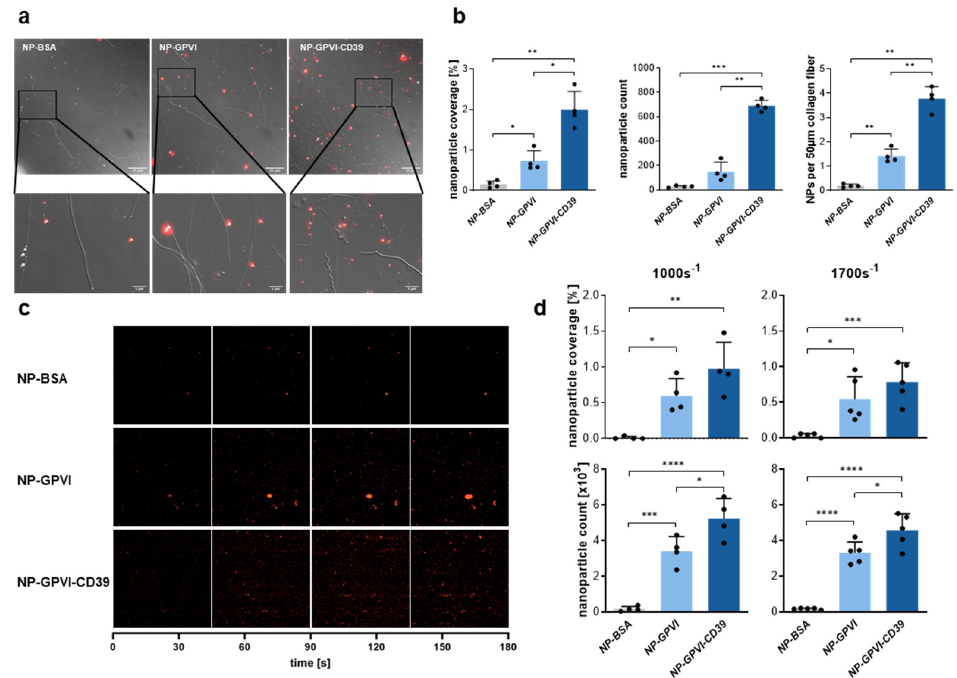
Figure 5. Collagen receptor GPVI-Fc- and GPVI-CD39-coated nanoparticles effectively bind to collagen fibers under both static and dynamic conditions. ( a ) Merged DIC and fluorescence microscopy images of nanoparticles adhered onto collagen coated cover slips after 1 h incubation at 37 °C. 100× magnification. Scale bar: upper row, 25 μ m; lower row, 5 μ m. ( b ) Statistical analysis of nanoparticle coverage, total nanoparticle count and nanoparticle count per 50 μ m of collagen fiber. Mean ± SD; n = 4; ordinary one-way ANOVA; * p ≤ 0.05, ** p ≤ 0.01, *** p ≤ 0.001. ( c ) Representative time-series images depicting nanoparticles adhering to collagen-covered cover slips in flow chamber experiments at HS (1700 s − 1 ). 20× magnification. ( d ) Statistical analysis of nanoparticle coverage and total nanoparticle count per shear rate of NP-GPVI, NP-GPVI-CD39 and NP-BSA. Mean ± SD; 1000 s − 1 : n = 4, 1700 s − 1 : n = 5; ordinary one-way ANOVA; * p ≤ 0.05, ** p ≤ 0.01, *** p ≤ 0.001, **** p < 0.0001.